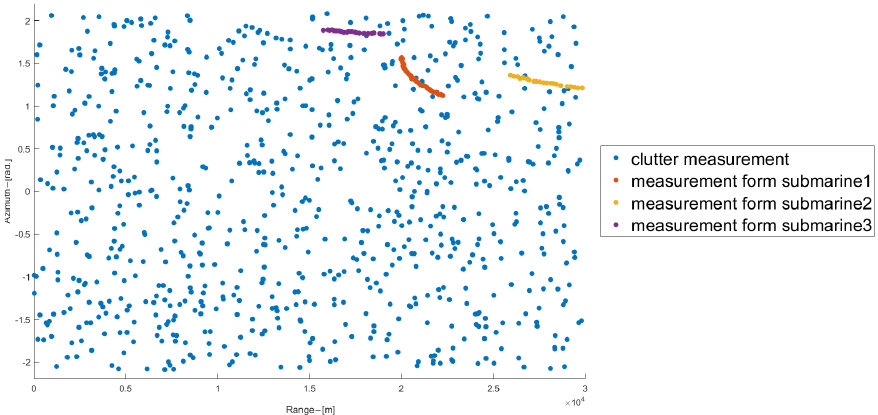
Figure 5. All measurements of sonar 1 within a single Monte Carlo experiment.